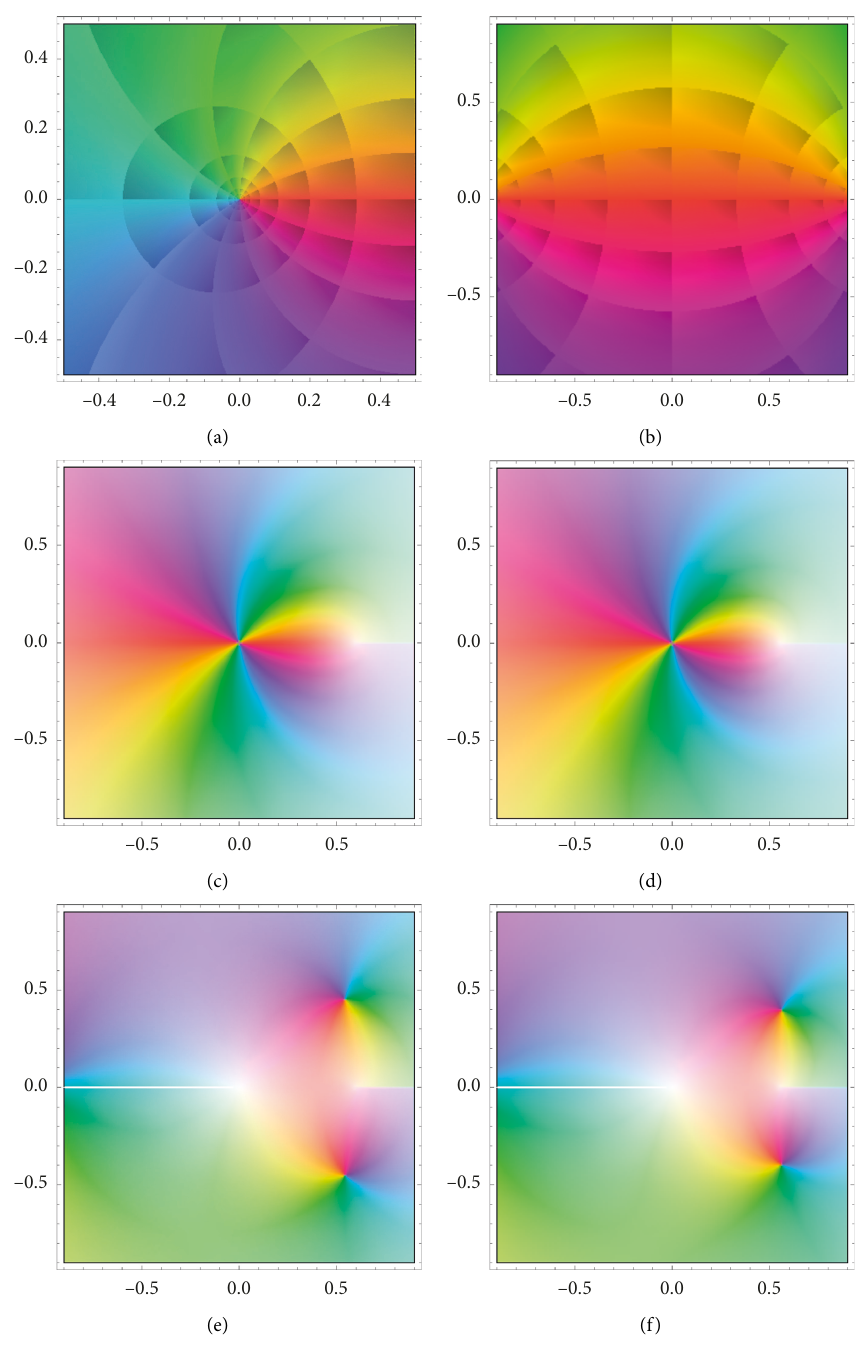
ψ ( ξ )] , when λ � 0 . 5 ,c � 0. (d) [ I υ α , β